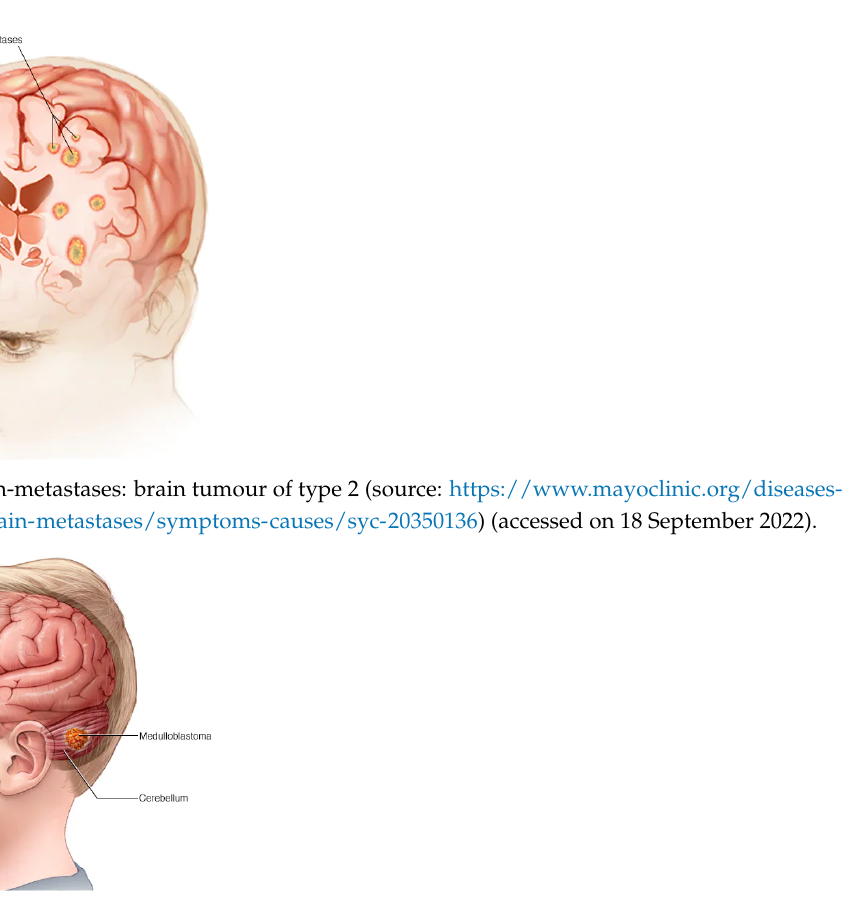
Table 2. Fuzzy parameterised values corresponding to ˆ ℘ i , i = 1,2,3,4.